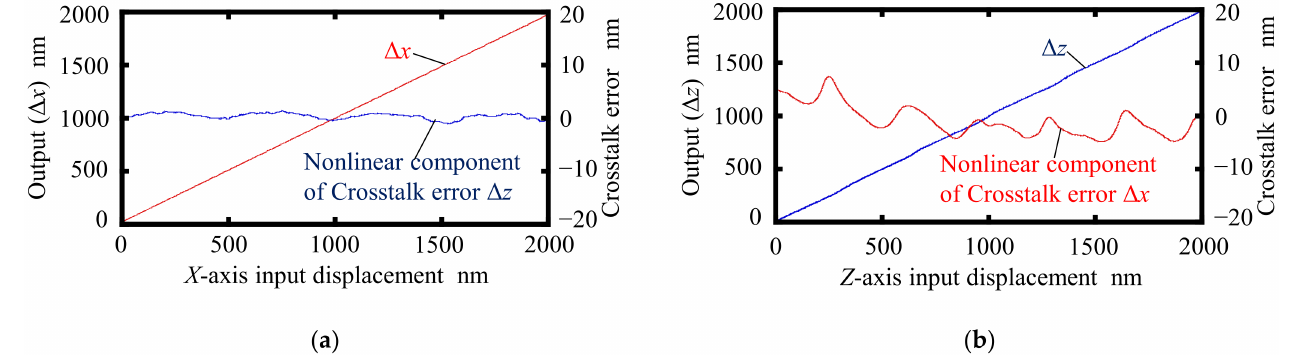
Figure 9. Non-linear component in the crosstalk error: ( a ) Reading of ∆ x and the nonlinear component of the reading of ∆ z when the X -directional displacement was applied; ( b ) reading of ∆ z and the nonlinear component of the reading of ∆ x when the Z -directional displacement was applied.